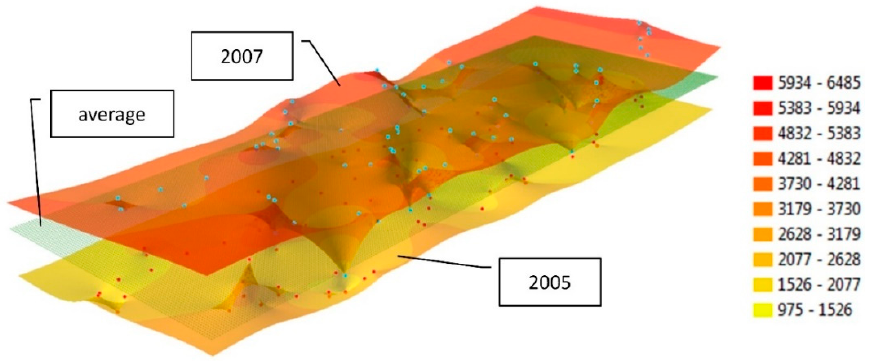
Figure 6. The location of interpolated surfaces relative to the overall average for the analyzed period; ( a , b ) comparison of extreme values in the analyzed period (a—2005, b—2007); ( c ) location of surfaces (values) that best fit the average (2014). Source: own elaboration.